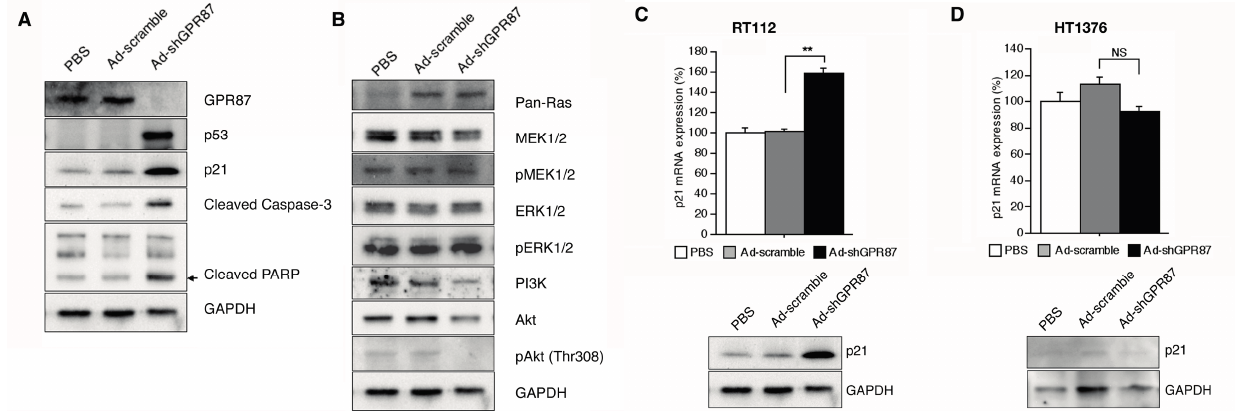
Figure 6. GPR87 promotes cell proliferation and inhibits apoptosis via the p53 pathway in RT112 cells. The RT112 cells were collected and analyzed 5 days after infection with Ad-shGPR87 at a MOI of 20. ( A ) The p53 and its downstream signal p21 protein expression severely increased. On the other hand; ( B ) the MAPK pathway was not changed, but the PI3K/Akt pathway was decreased significantly. The gene expression ( upper panel) and protein expression ( lower panel) of p53 downstream gene p21 were also increased significantly in the wild-type p53 RT112 cells ( C ), but not in the mutant p53 HT1376 cells ( D ). Three independent experiments were performed for evaluating gene expression with real-time PCR or protein expression with western blot analyses. MOI: multiplicity of infection; ** p < 0.005, vs. Ad-scramble treatment; NS, not